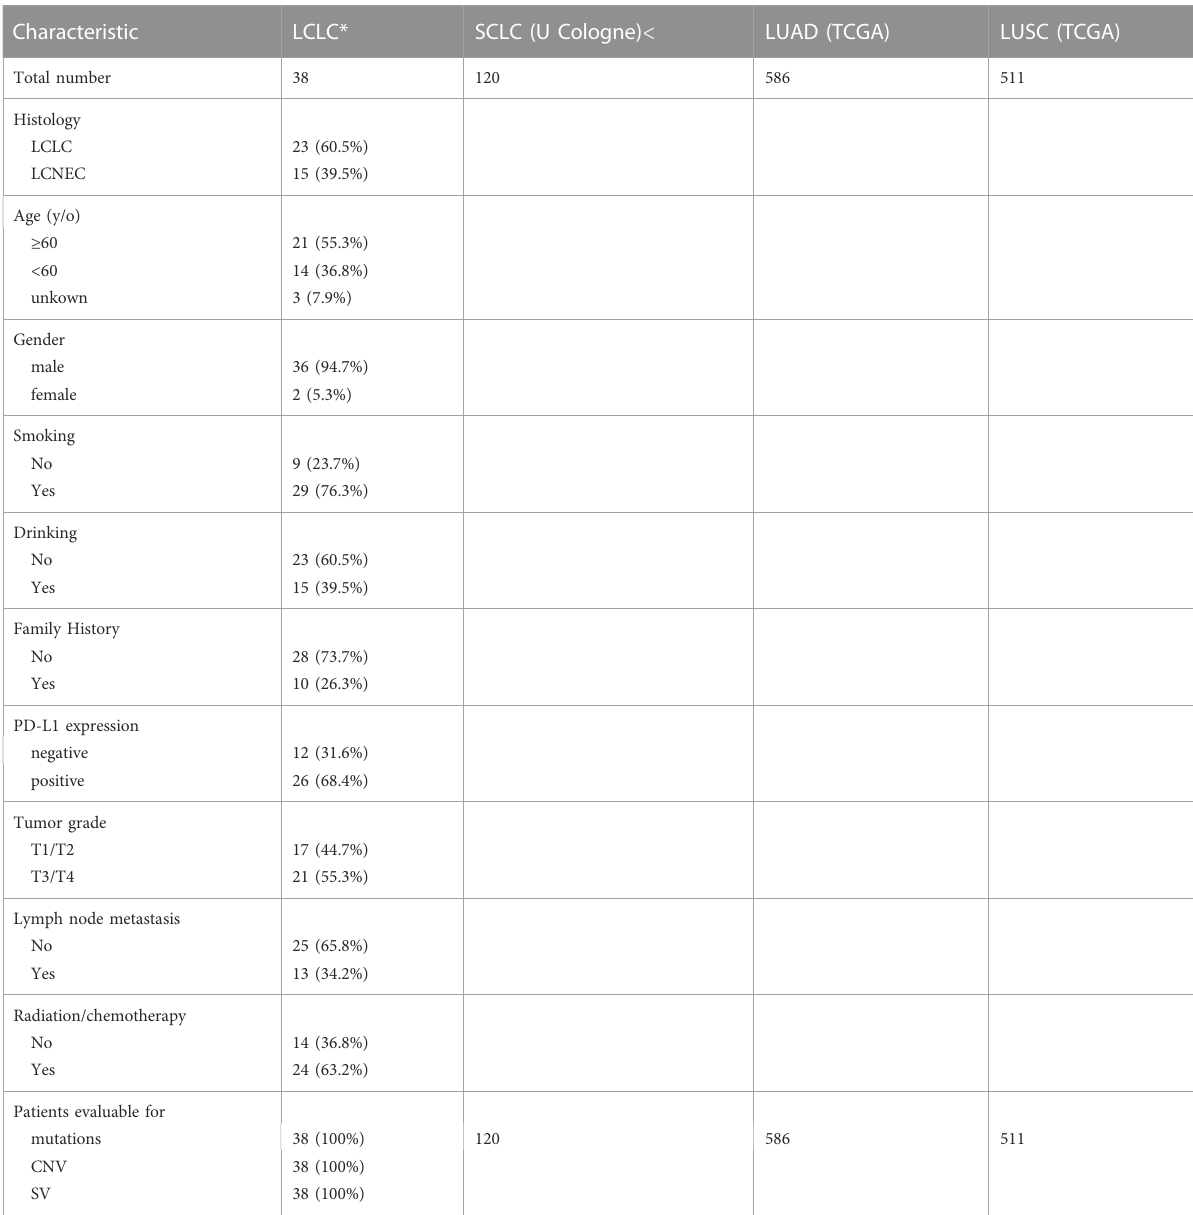
TABLE 1 The patient characteristics and clinicopathological